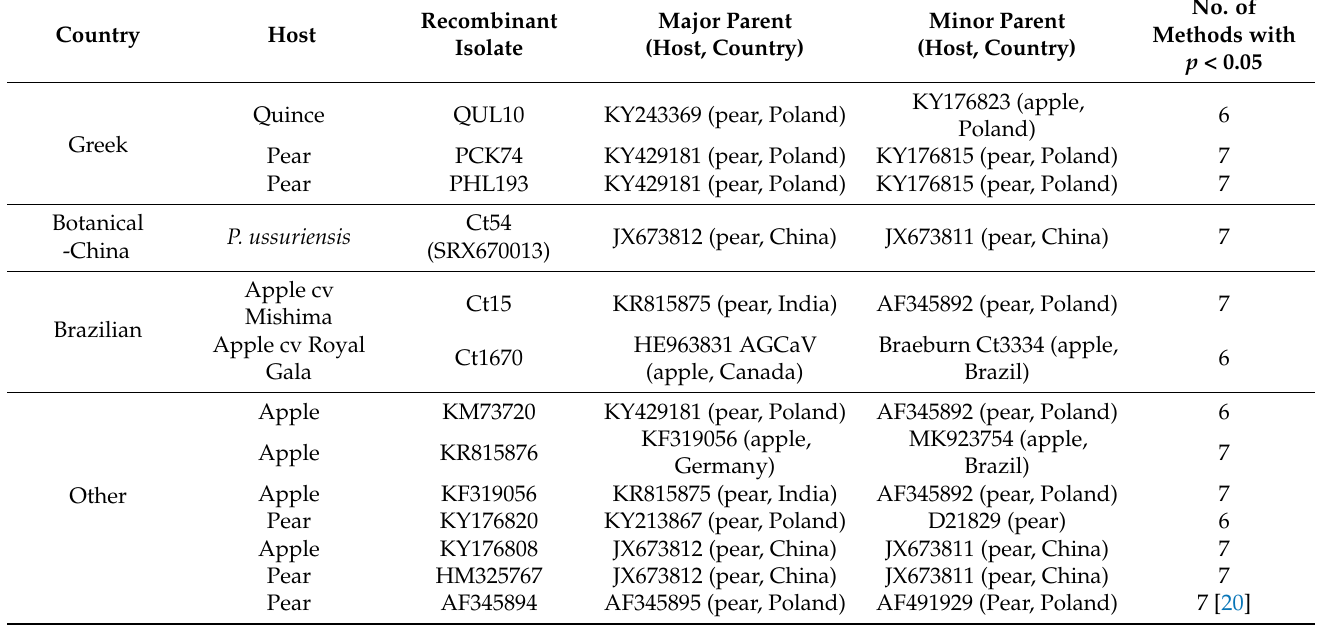
Table 2. List of potential recombination events involving ASPV CP gene sequences detected by RDP, GENECONV, Chimaera, MaxChi, BootScan, SiScan and 3Seq methods using RDP4 program.